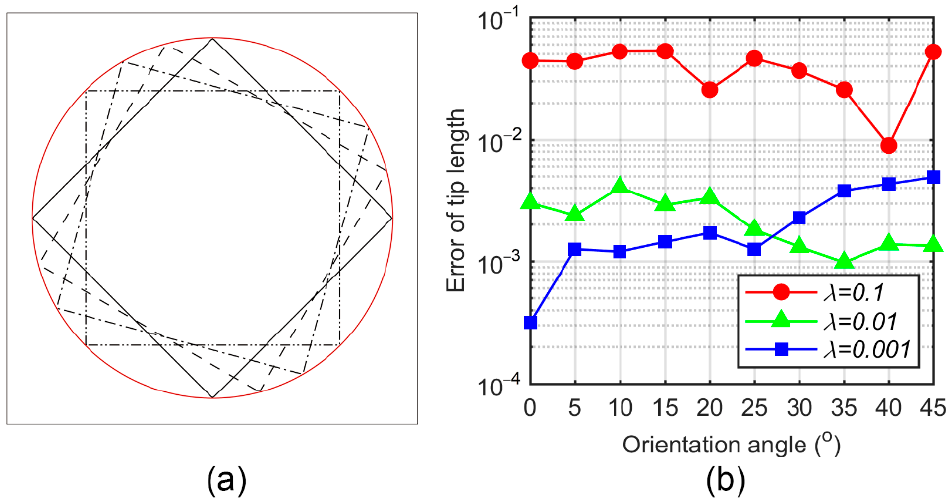
Figure 5. ( a ) Grain shape with orientation angle of 0°, 15°, 30° and 45°; the radius of the red circle is the theoretical tip length; ( b ) Error of tip length with different orientation angles and parameter λ .